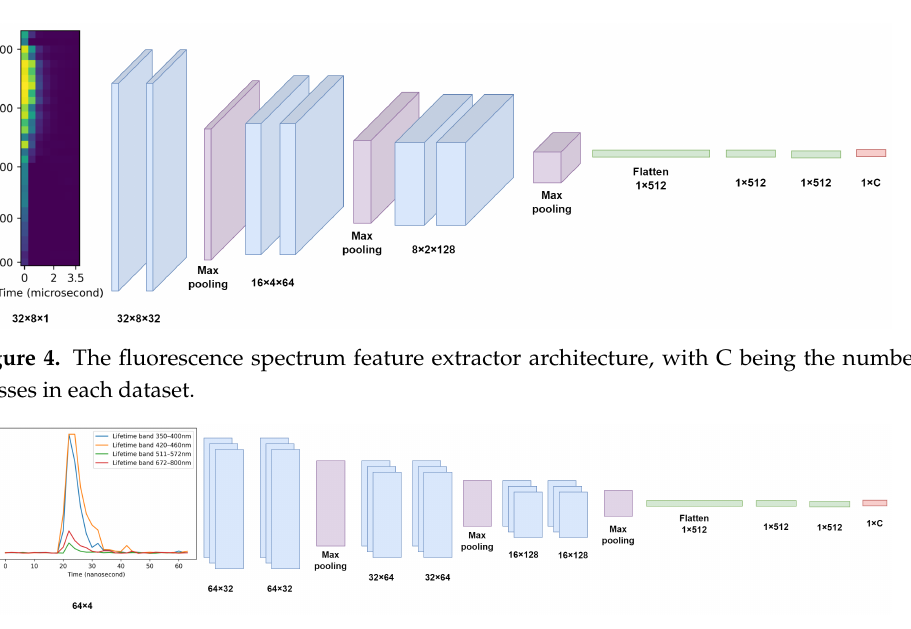
Figure 5. The lifetime signal feature extractor architecture, with C being the number of classes in each